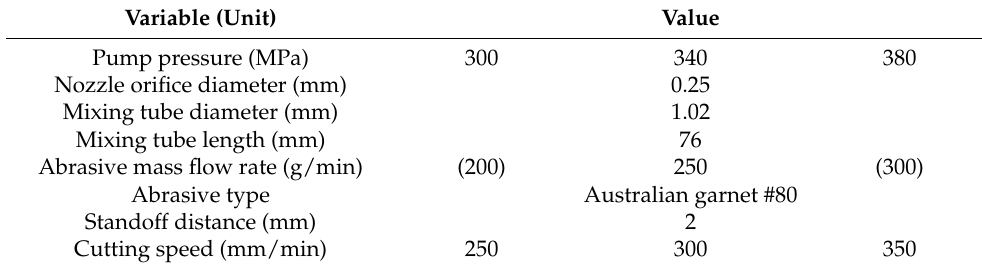
Table 2. Parameters and factors affecting the AWJM